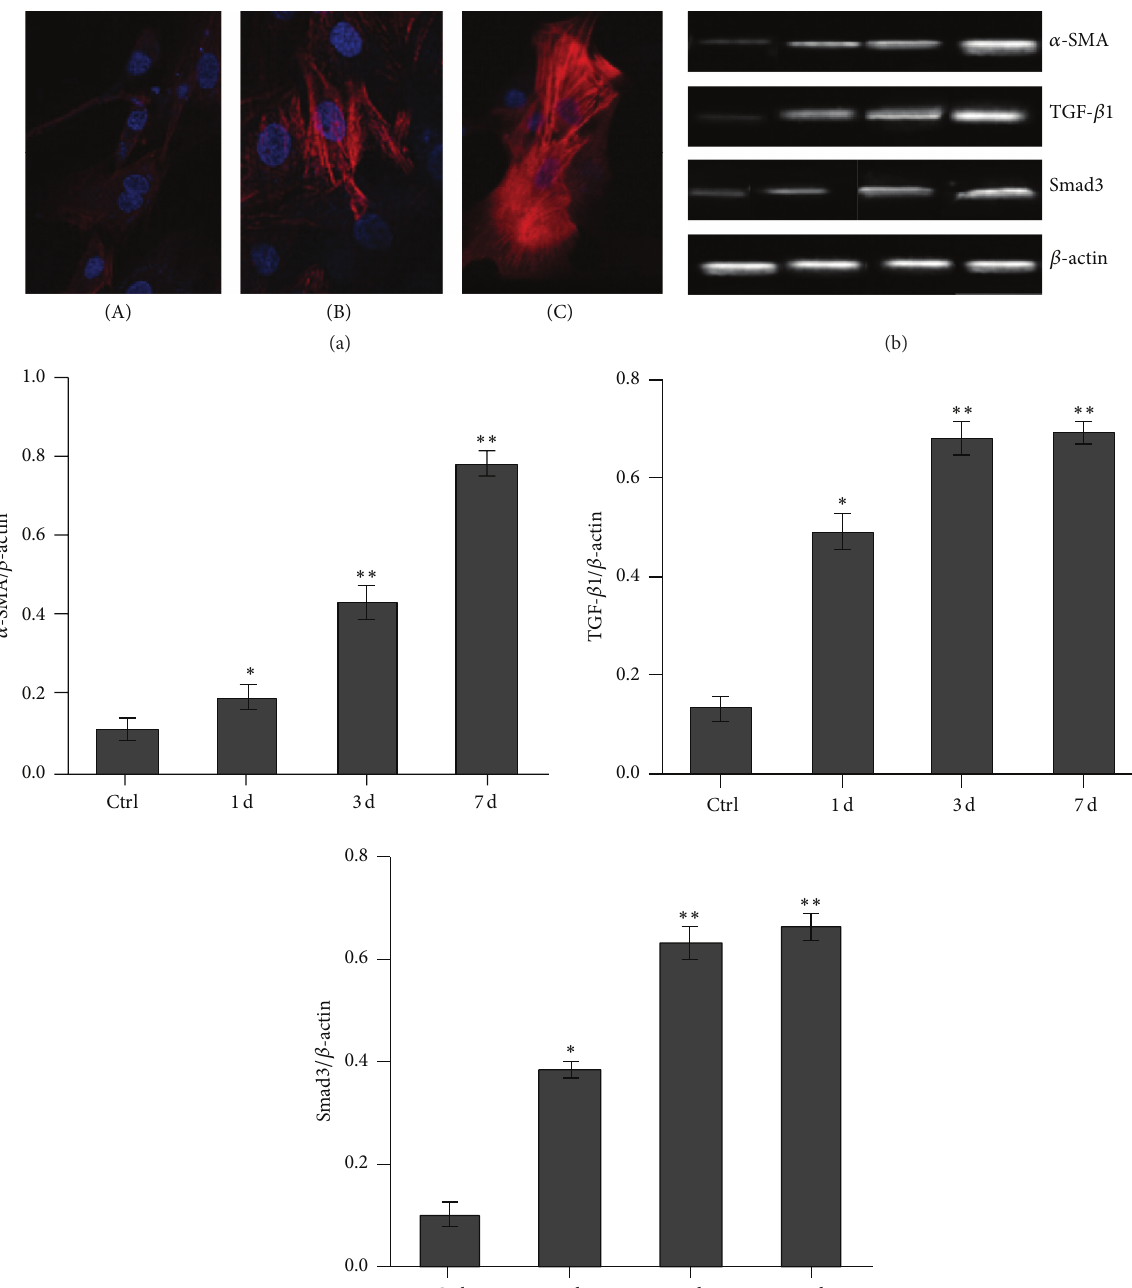
Figure 3: Myogenic induction of BMSCs. (a) Immunofluorescence expressions of BMSCs. (A–C) BMSC treated with anti- 𝛼 -SMA showing a blue-stained nucleus and a red-stained cytoplasm after coculture for 1, 3, or 7 days ( × 400); 𝛼 -SMA expressions of BMSCs positive rates were 23% at 1 day, 49% at 3 days, or 82% at 7 days. (b) Expressions of 𝛼 -SMA, TGF- 𝛽 1, and Smad3 mRNA in BMSCs showing significant differences among the four groups were indicated by RT-PCR. (c) Results represent the average of at least six independent experiments ( 𝑛 = 6 ). Bars indicate the mean ± SD. ∗ 𝑃 < 0.05 compared to the control (model versus control, ∗ 𝑃 < 0.05 ; the model group for 3 days or 7 days versus 1 day, ∗∗ 𝑃 < 0.05